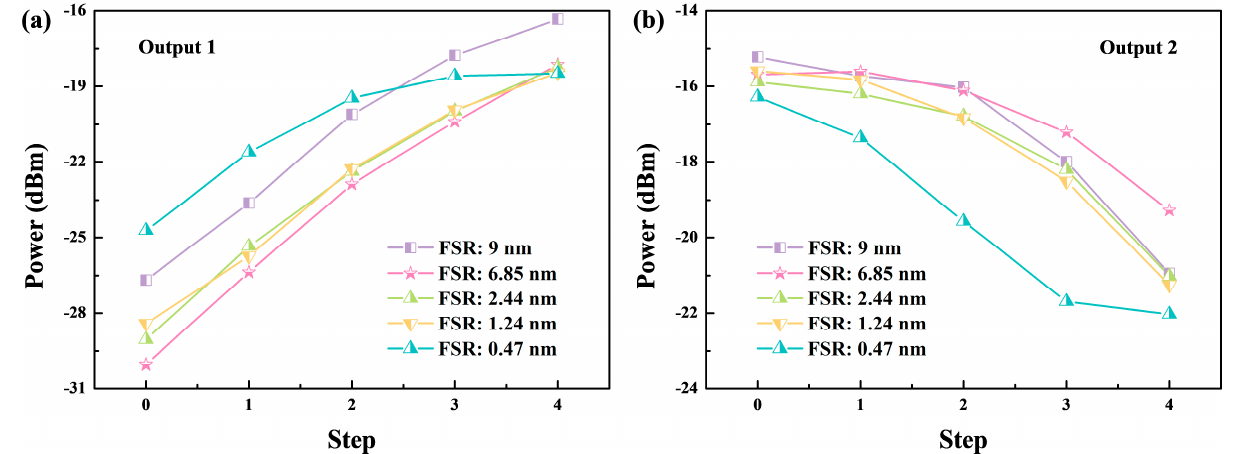
Figure 4. The power variation curves in the same number of steps via the results of Figure 3, where the FSR of the TDI and the strain applied to each step are 800 με strain for 9 nm FSR, 500 με strain for 6.85 nm FSR, 200 με strain for 2.44 nm FSR, 100 με strain for 1.24 nm FSR, and 40 με strain for 0.47 nm FSR. ( a ) When the power change is measured from the TDI output 1, the FBG is strained from the lobe trough where the slope is large until the FBG wavelength shifts to about two-thirds of the FSR half ( b ) when the power change is measured from the TDI output 2, the FBG is strained from the lobe peak where the slope is small until the FBG wavelength shifts to about two-thirds of the FSR half.